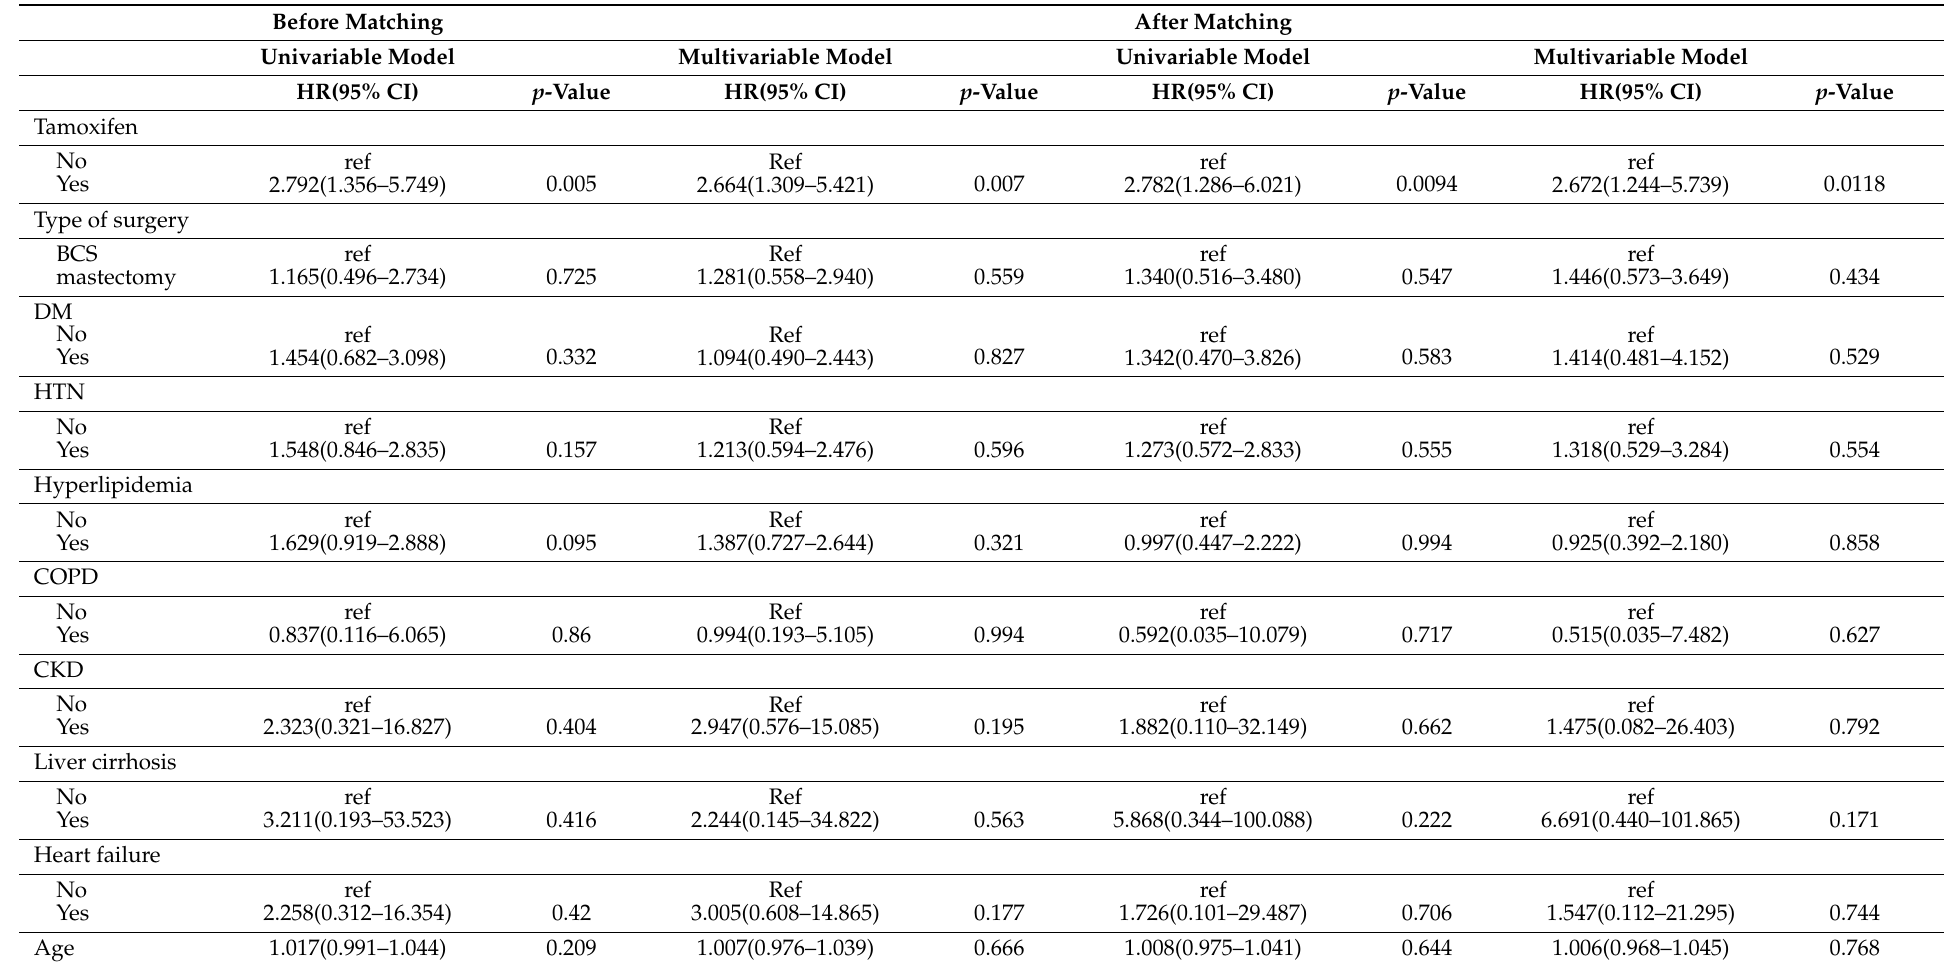
Table 2. Univariable and multivariable analysis of endometrial cancer risk